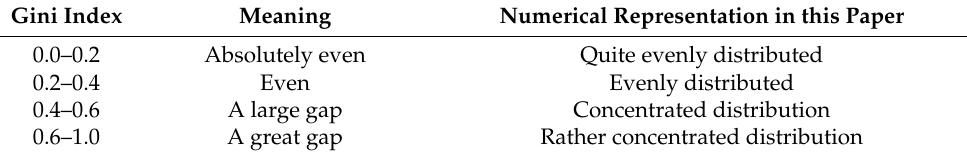
Table 1. Types of Gini